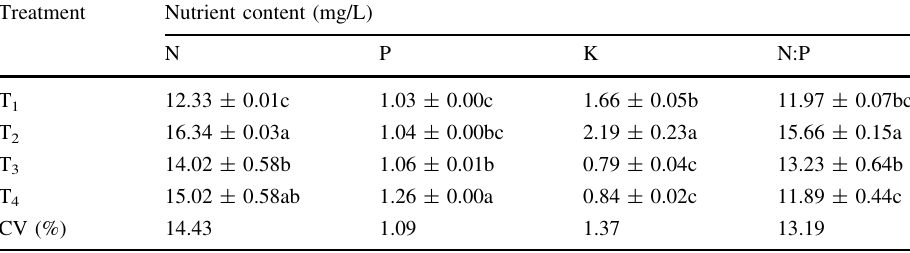
Treatment Nutrient content